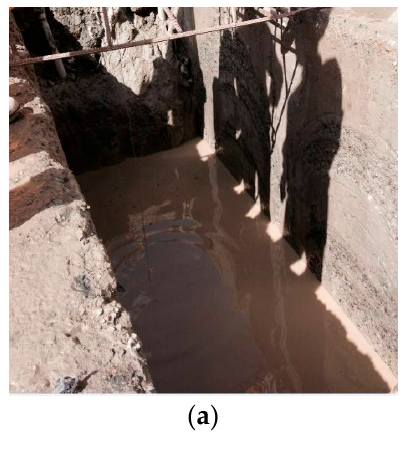
Table 2. Chemical composition of cement.